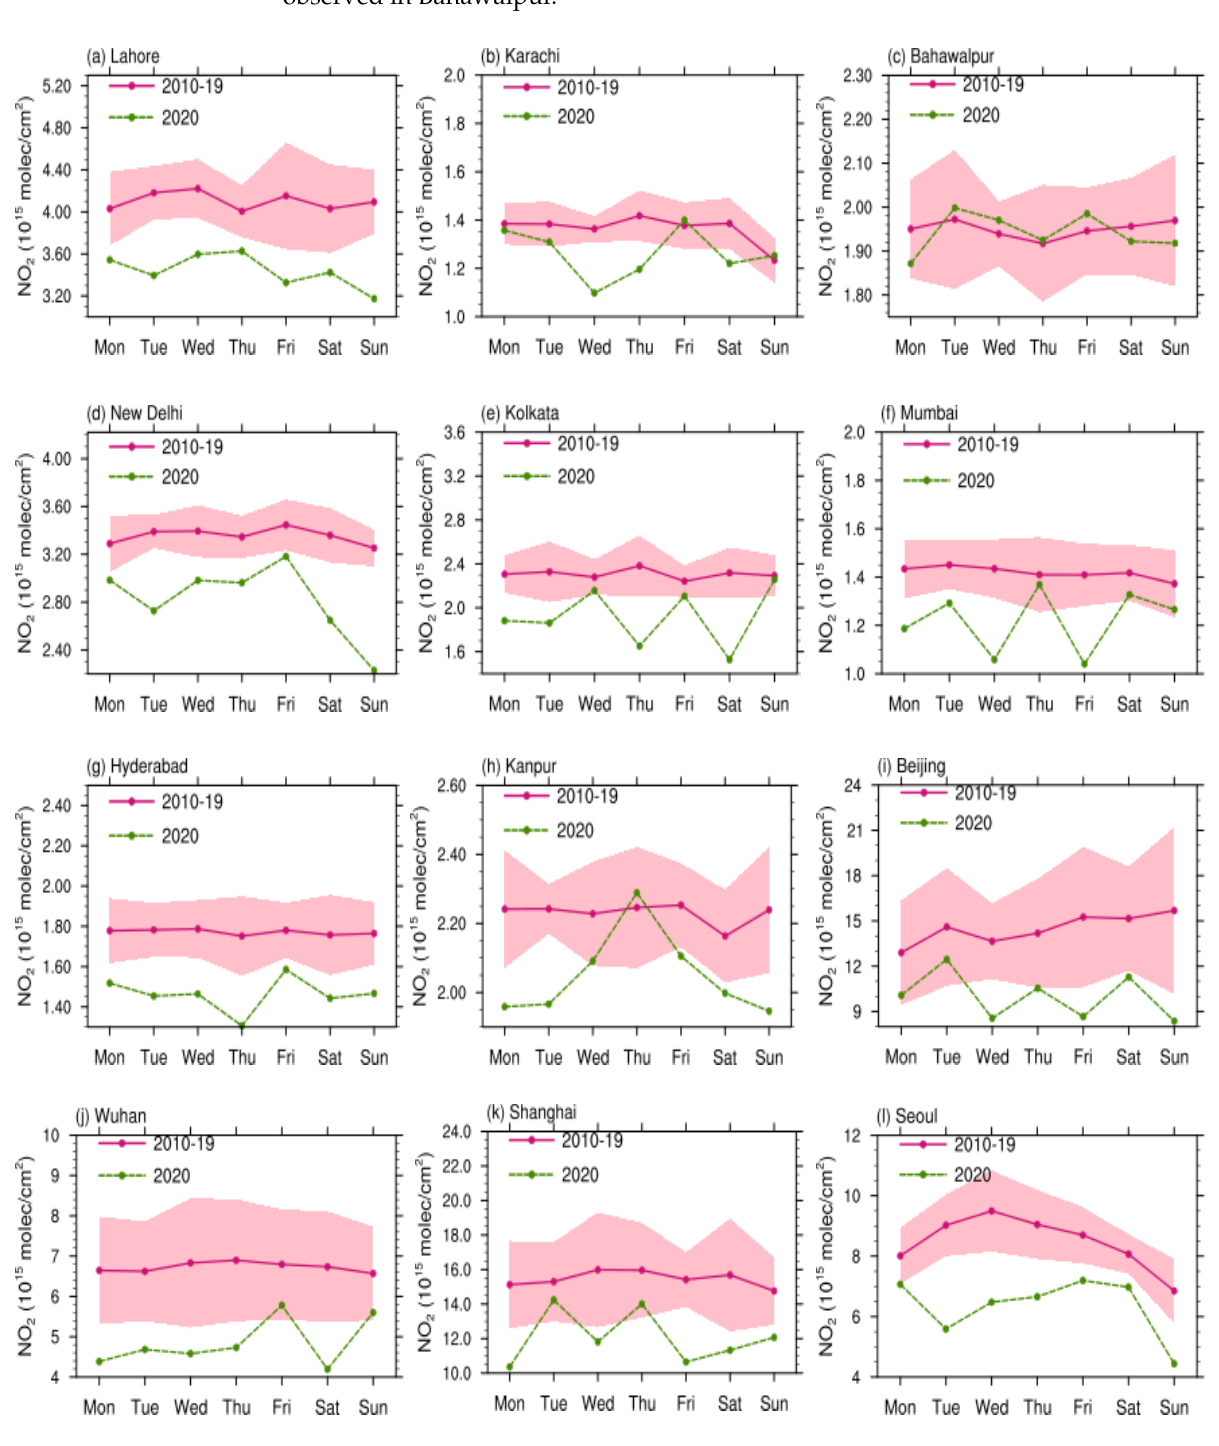
Figure 2. Variations in weekly tropospheric NO 2 in 2010–2019 and 2020, before (pink line) and during (dotted green line) COVID-19, with standard deviation (pink shading) in ( a ) Lahore, ( b ) Karachi, ( c ) Bahawalpur, ( d ) New Delhi, ( e ) Kolkata, ( f ) Mumbai, ( g ) Hyderabad, ( h ) Kanpur, ( i ) Beijing, ( j ) Wuhan, ( k ) Shanghai, and ( l ) Seoul.